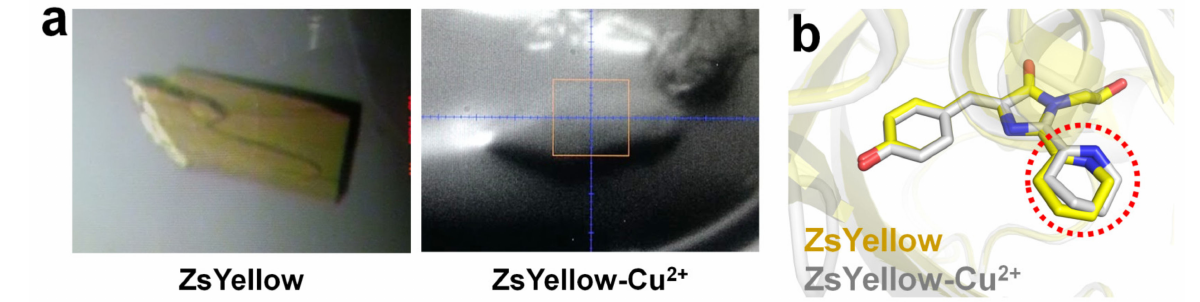
Figure 7. Crystallographic study of ZsYellow. ( a ) Color change of the ZsYellow crystal by Cu 2+ solution soaking. ( b ) Comparison between the chromophore of the native and Cu 2+ -soaked ZsYellow. Original figures were obtained from a previous study [92] and